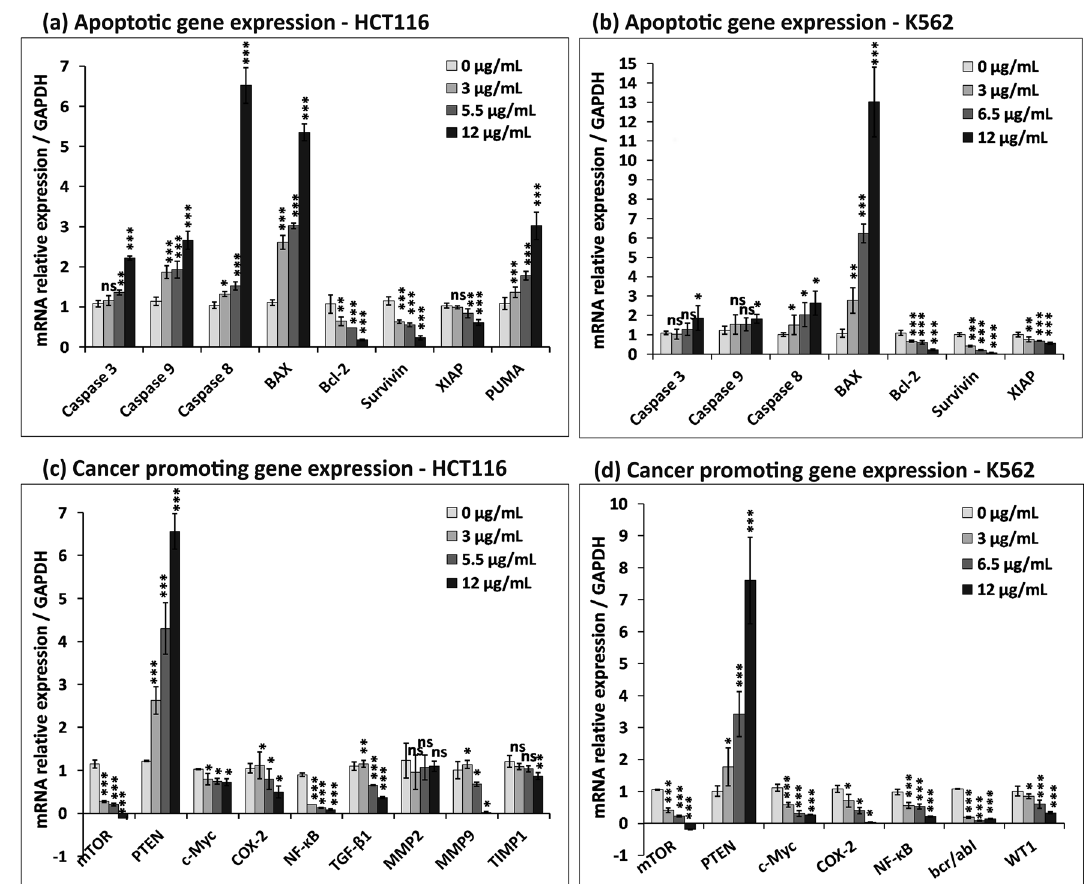
Figure 8. Quantitative transcriptional profiling of CMRP treated K562 and HCT116 cells using RT-qPCR. ( a ) and ( b ) Bar diagram representing fold-changes in the relative expression of mRNA from apoptotic genes and ( c ) and ( d ) those from cancer promoting genes, normalized to that of GAPDH gene. Data represents mean ± SD of three independent experiments; ns—not significant, * P < 0.05, ** P < 0.01, *** P <